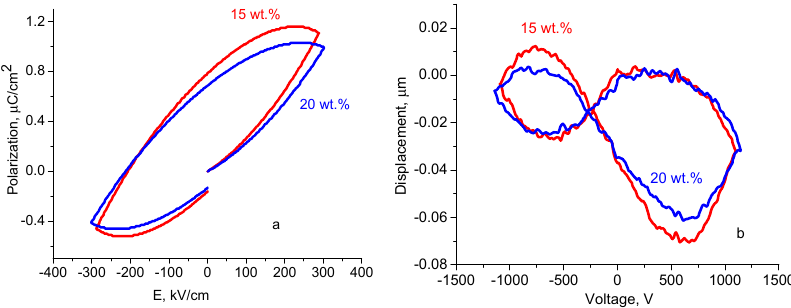
Figure 6. Ferroelectric hysteresis curve of ( a ) CS-ZnO NPs nanocomposites, ( b ) corresponding deformation curve Δ l vs. V for CS-ZnO films with different wt.% of NPs indicate on the graph.